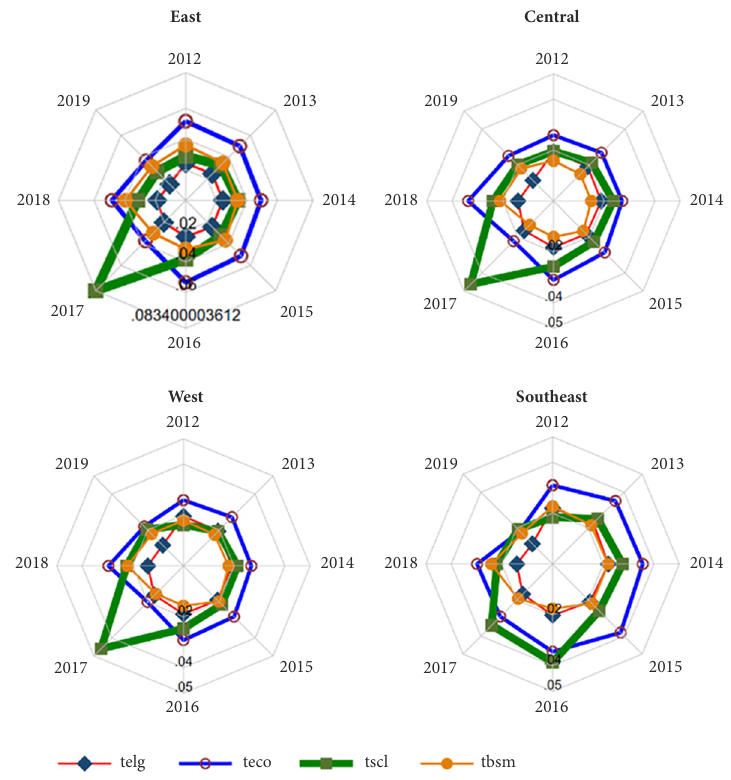
Figure 2. Trends in sub-items of the urban resilience index in China and four regions from 2012 to